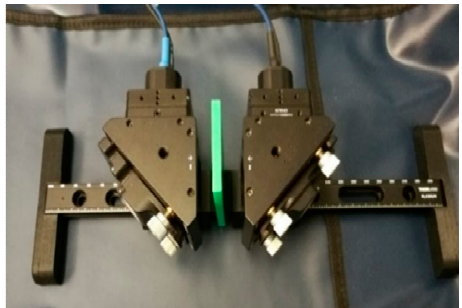
Figure 1. Experimental setup with photoconductive antennas (PCAs) and plastic sample in green. The experiment involved five different categories of samples with individual inor- ganic pigments, which differed in five colors, white, blue, green, yellow, and black. The geometrical parameters of the samples were equal in all the used batches. The samples with different pigments are presented in Figure 2.